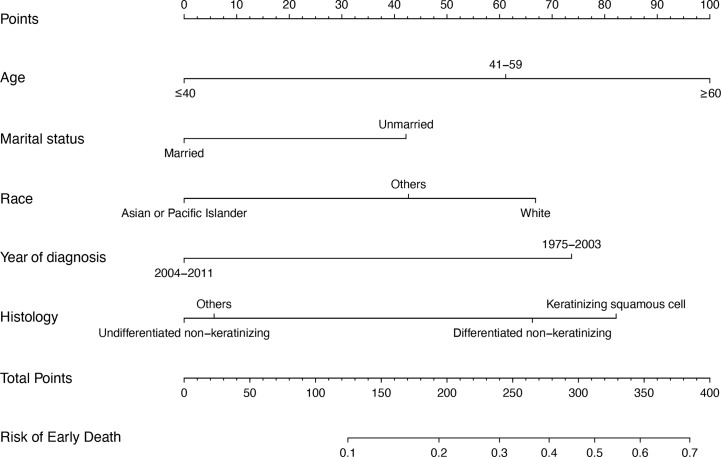
The nomogram model for predicting ED probabilities of patients with localized NPC. For example, there is one patient with localized NPC older than 60 (100 points), with married status (0 point), the race of Asian (0 point). He is diagnosed in 2010 (0 point), and the histology type is differentiated non-keratinizing tumor (60 points). These five values summed to 160 points. Therefore, we determined that the risk of ED was 0.1–0.2.